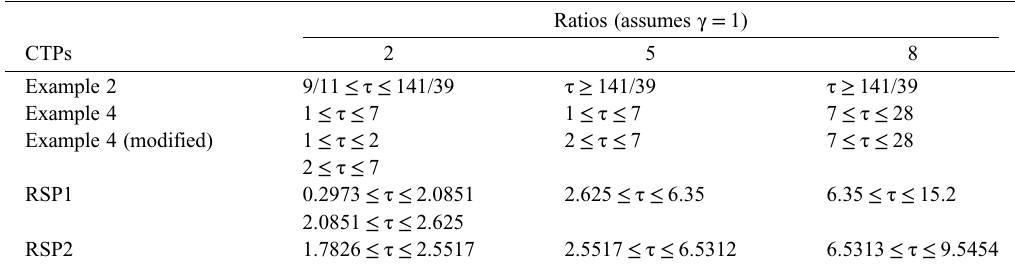
CTP sensitivity analyses Ratios (assumes γ =